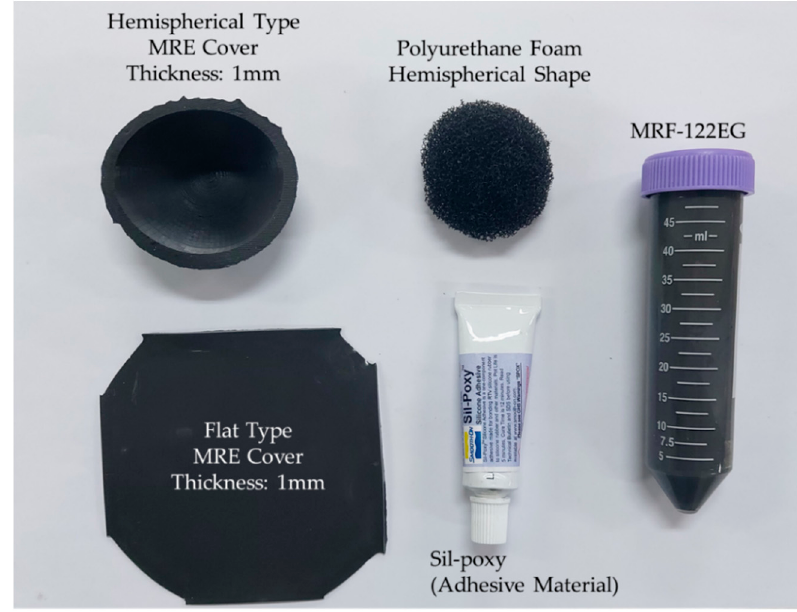
Figure 9. Components photos of the proposed MRTTC.